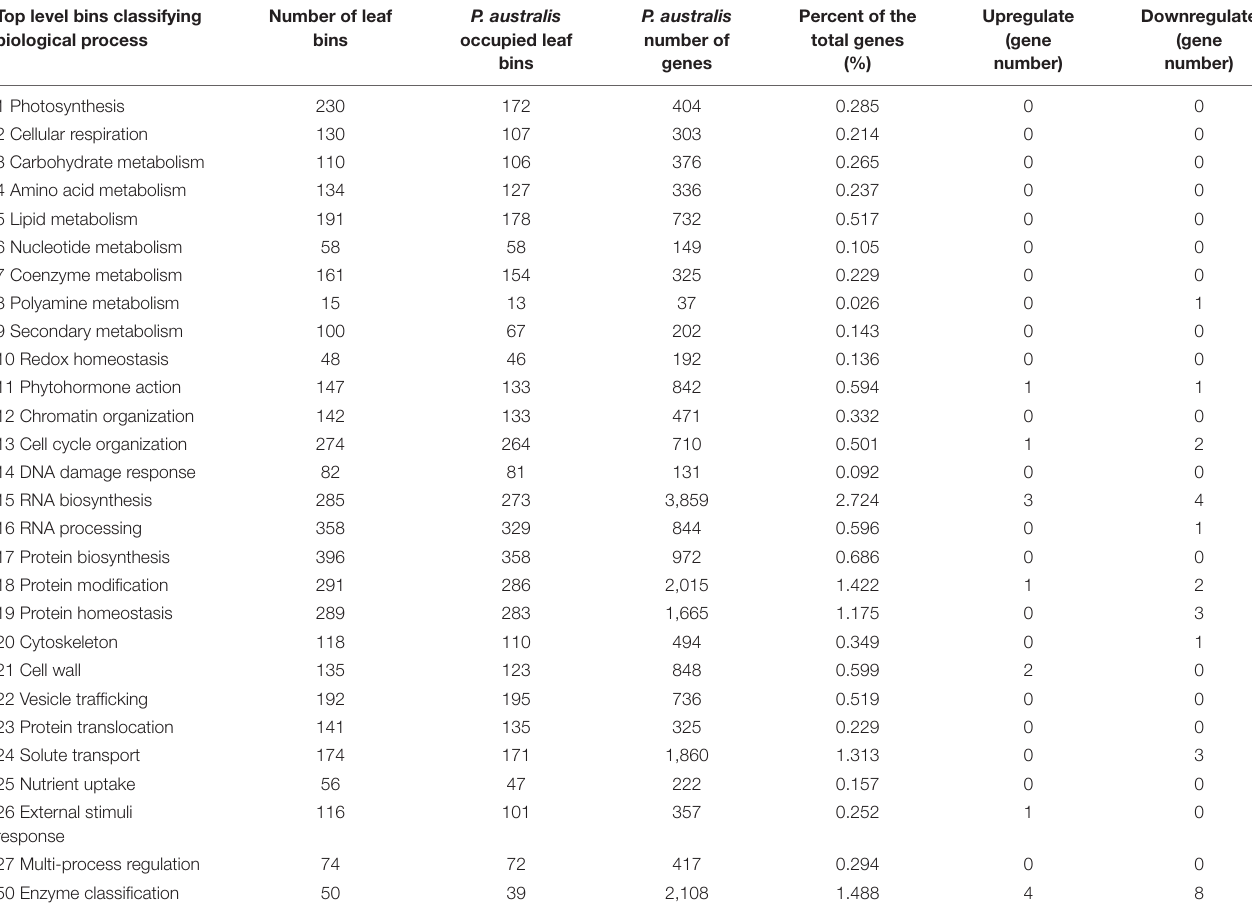
TABLE 2 | Gene annotation inferred by